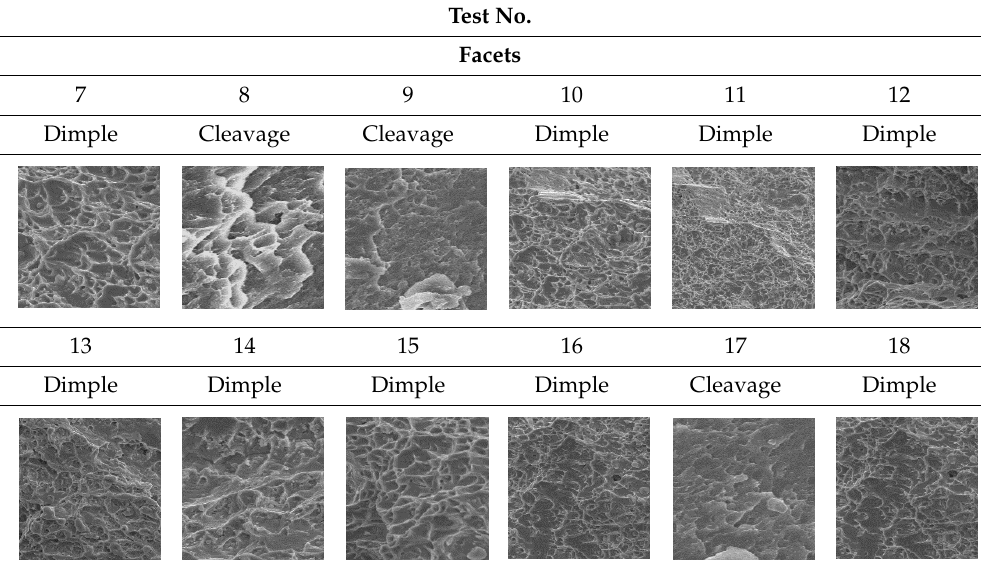
Table 7. Results of fracture geometry analysis of the heat-affected zone according to the Charpy impact test.